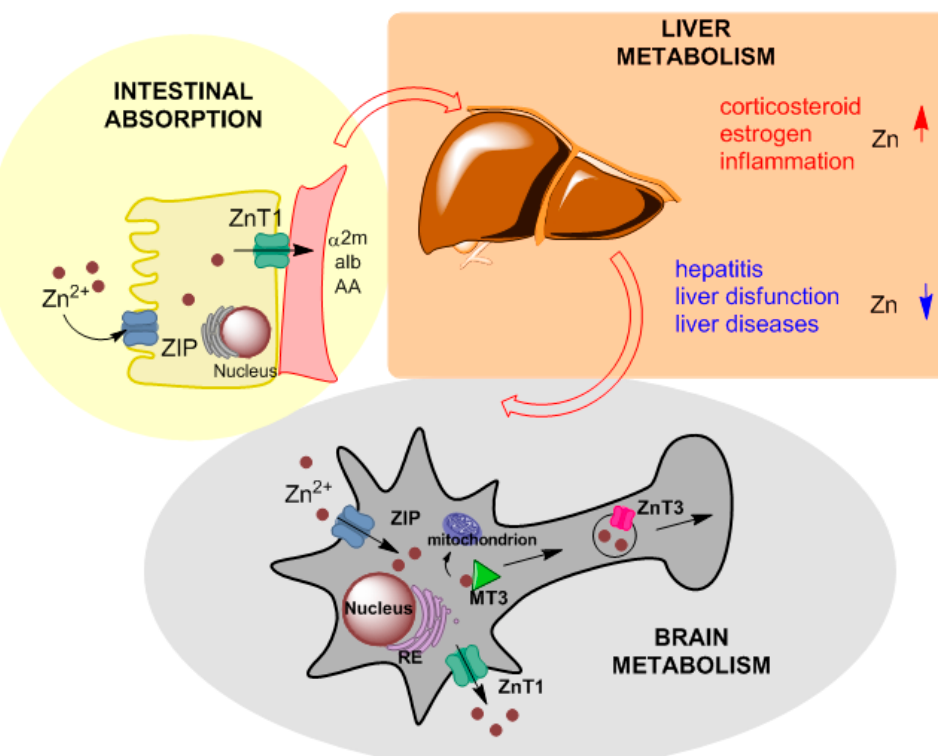
Figure 1. General zinc absorption and metabolism. Intestine: zinc is absorbed in the small intestine and is responsive to dietary intake. ZnT and Zip transporters have opposite role within the cell: Zip transporters in increasing cytoplasmic zinc concentrations while ZnT in decreasing it, in particular ZnT1 is located in small intestine and regulates zinc release from the enterocyte to general circulation. Zn 2+ is tightly bound to α 2-macroglobulin ( α 2m) and loosely to albumin (Alb) and other proteins, peptides and amino acids (AA) which serve as primary sources of zinc accessible to all cells. Liver: The liver plays a central role in zinc metabolism as well. Corticosteroids, estrogens and inflammation decrease plasma zinc, associated to an increase of zinc in the liver. Hepatitis, liver dysfunction, or liver diseases with fulminant, but also chronic or subacute hepatic failure are associated with low levels of zinc. Reduced levels of zinc are found in alcoholic hepatitis patients, while they are less decreased in nonalcoholic liver disease. Brain: zinc is necessary for brain development and physiology. The Zn 2+ ions could be transported into neurons by the transmembrane ZiP proteins. Once inside the accumulation and trafficking of Zn 2+ are directed by members of ZnT family. ZnT1, 3, and 6 are abundant in the brain and central nervous system (CNS). The homeostasis of Zn 2+ in the brain is also regulated by the MT3 protein. Zinc is sequestered into presynaptic vesicles by ZnT3, which is coupled with vesicular glutamate transporter (not shown); zinc is then released into synaptic cleft together with glutamate (not shown). Zinc is finely regulated in the body and this limits its potential toxic effects, even at high dosage, particularly within the brain. In this organ, toxicity is triggered when the endogenous zinc fluxes within the cells are disturbed, e.g., after transient global ischemic insults that trigger excitotoxic processes, caused by excessive release of glutamate neurotransmitter at the synapse. Ca 2+ , but also Zn 2+ concentrations, buildup within the cell during excitotoxicity and prompt neurodegeneration [12], in this case, zinc toxicity could be prevented by the intraventricular injection of zinc-chelating agents [41,42]. The mechanisms by which zinc exerts its toxicity during ischemic insults seems to be ascribable to structural abnormalities in tubulin or microtubule